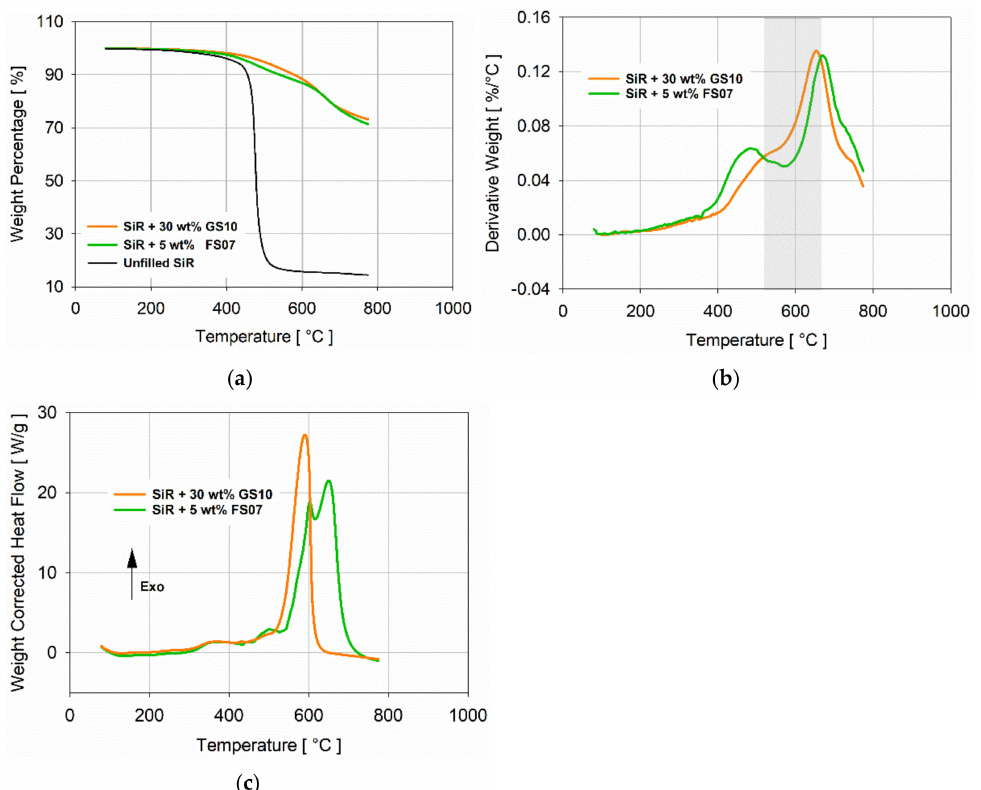
Figure 6. ( a ) Thermogravimetric analysis (TGA) for the prepared composites and the unfilled SiR in an N 2 atmosphere. ( b ) Corresponding differential thermogravimetric analysis (DTGA) plot for the silica filled composites. ( c ) DTA for the prepared composites in an air